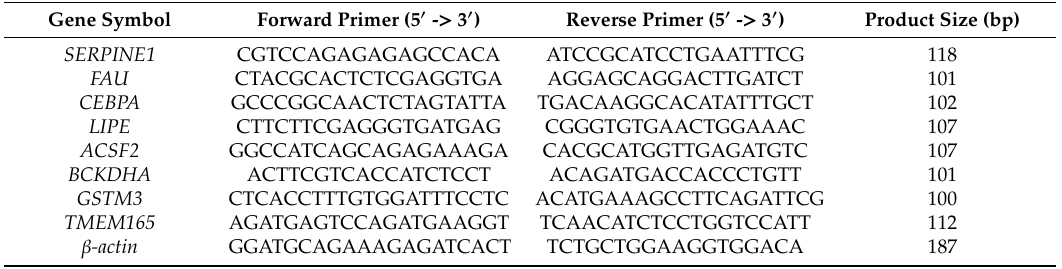
Table 1. Names, primer sequences and product sizes of the candidate